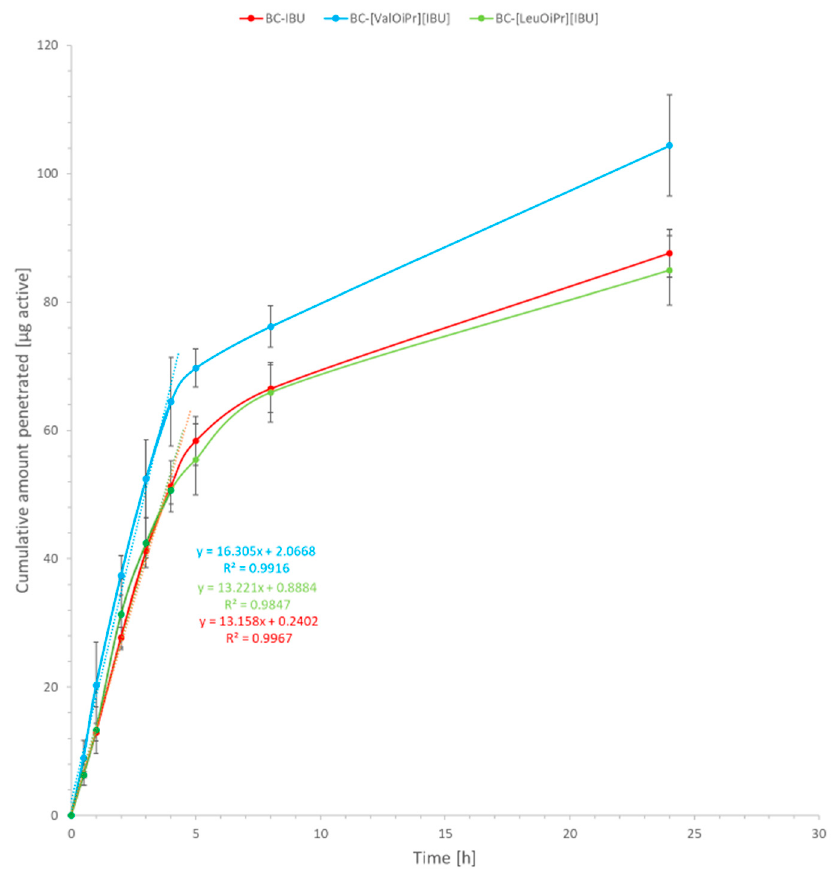
Figure 5. Ibuprofen permeation across pigskin. Mean values ± standard deviation, n = 3.